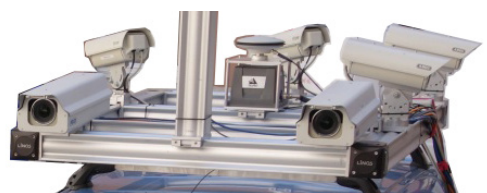
Figure 2. Sensor configuration of the IVGI MMS